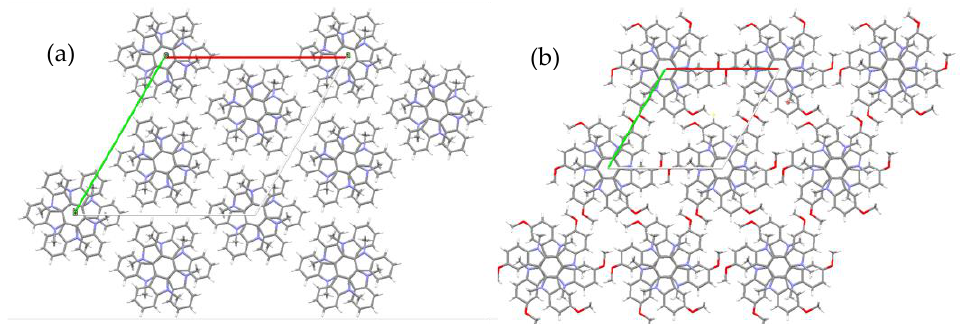
Figure 5. View of the packing of 1 ( a ) and 2 ( b ) along the crystallographic c axis. Along the columns the molecules orient face-to-face in an alternate arrangement, each molecular unit rotated by 60 ◦ with respect to its next neighbors in the stacks and with the central aromatic rings perfectly superimposed. Within the stacks, the N -trimethyltriindole units ( 1 ) are situated at two different distances that alternate along the column reflecting the steric hindrance by the methyl groups (centroid–centroid distance of the central aromatic rings of two adjacent molecules are 3.53 Å and 3.68 Å), while in the trimethoxy derivative 2 (with the methyl groups within the molecular plane) only one repeating distance is observed (3.49 Å ).